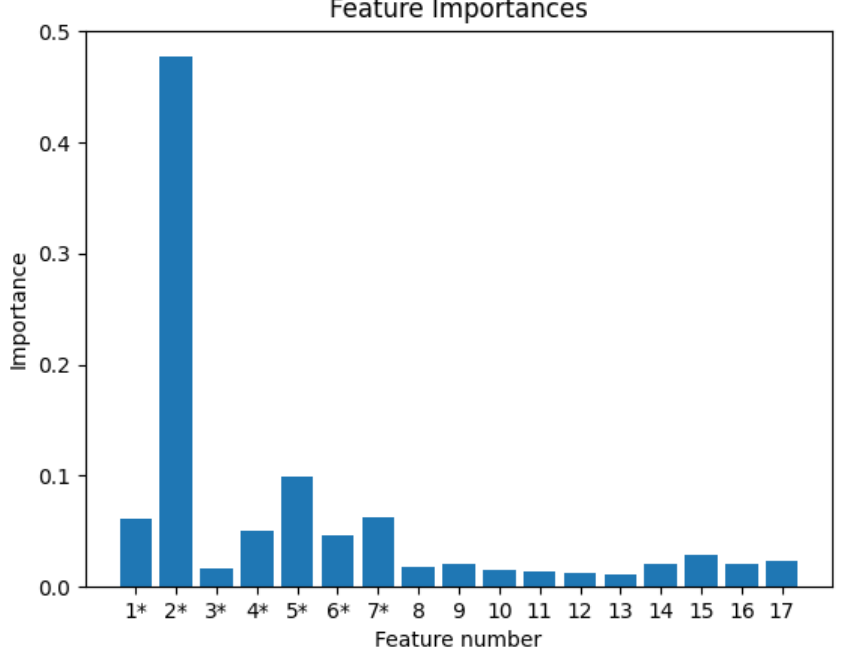
Figure 6. Feature importance according to a random forest. The descriptions of features 1* to 7* are shown in Table 2. The feature numbers 8 to 17 represent the standard deviations of the 10 solution curves with the greatest fluctuations. Table 2. The features selected using the random